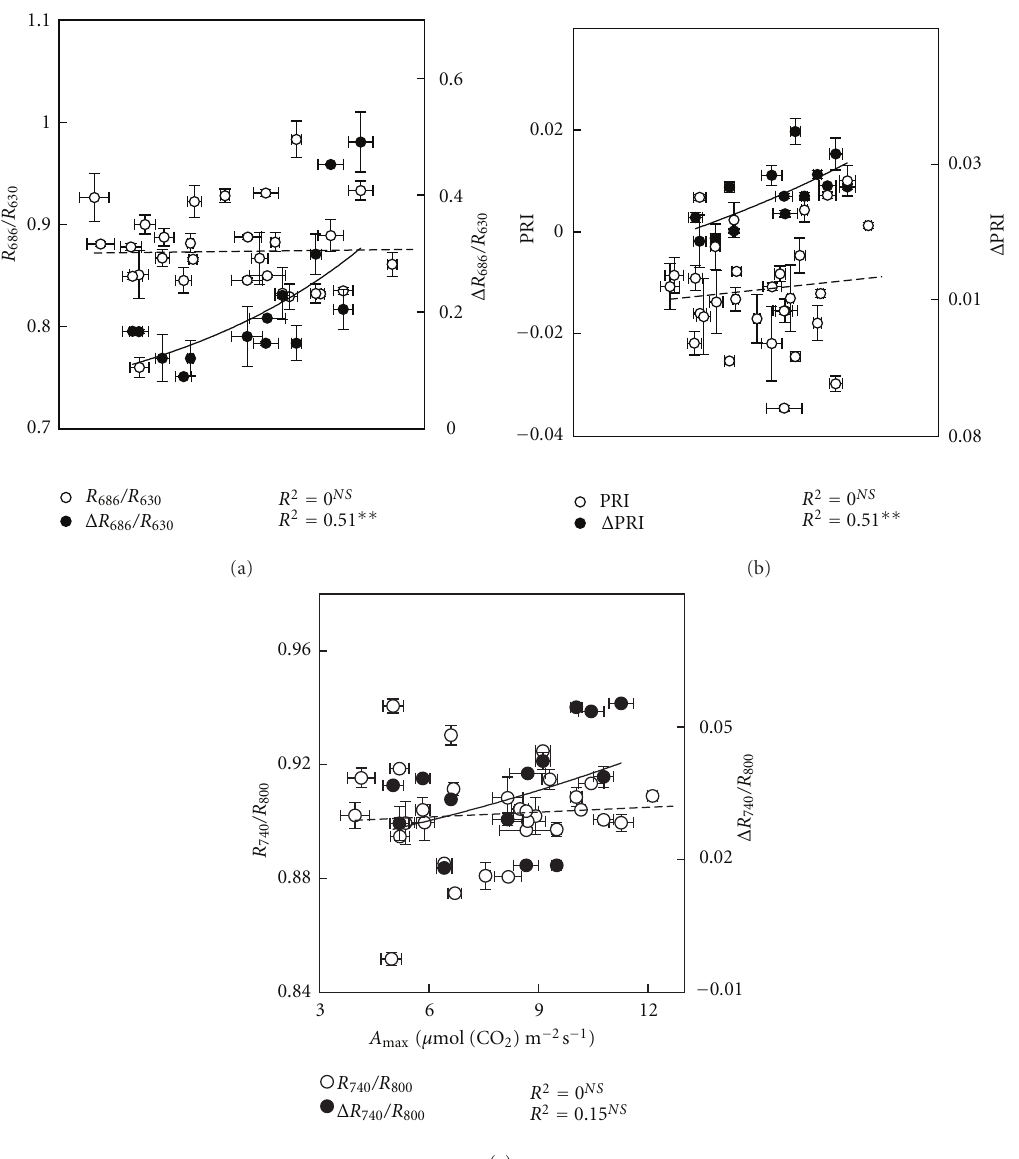
Figure 2: Midday relationships between light-saturated CO 2 assimilation rate ( A MAX ) and selected vegetation indices ((a): R 686 / R 630 , (b): PRI Physiological Reflectance Index, ( R 532 − R 570 )/( R 532 + R 570 )) and (c): R 740 / R 800 under saturating steady state light conditions (transparent dots); and the relative change of the vegetation indices ( Δ ) during the dynamic transition of plants form dark-to-light adapted state (dark dots). 24 leaves (of 6 di ff erent plant species) were measured and each dot represents the mean value of five measurements for A MAX and 8–10 measurements (pixels) for the reflectance indices per one leaf. Error bars represent standard deviations. NS means nonsignificant